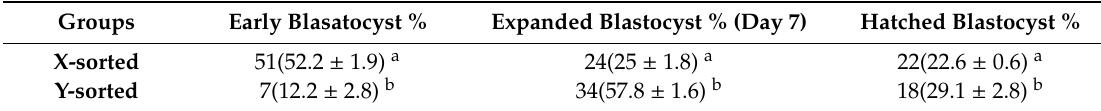
Table 1. Blastocyst development analysis using sex-sorted sperm from a KPN-917 bull. Groups